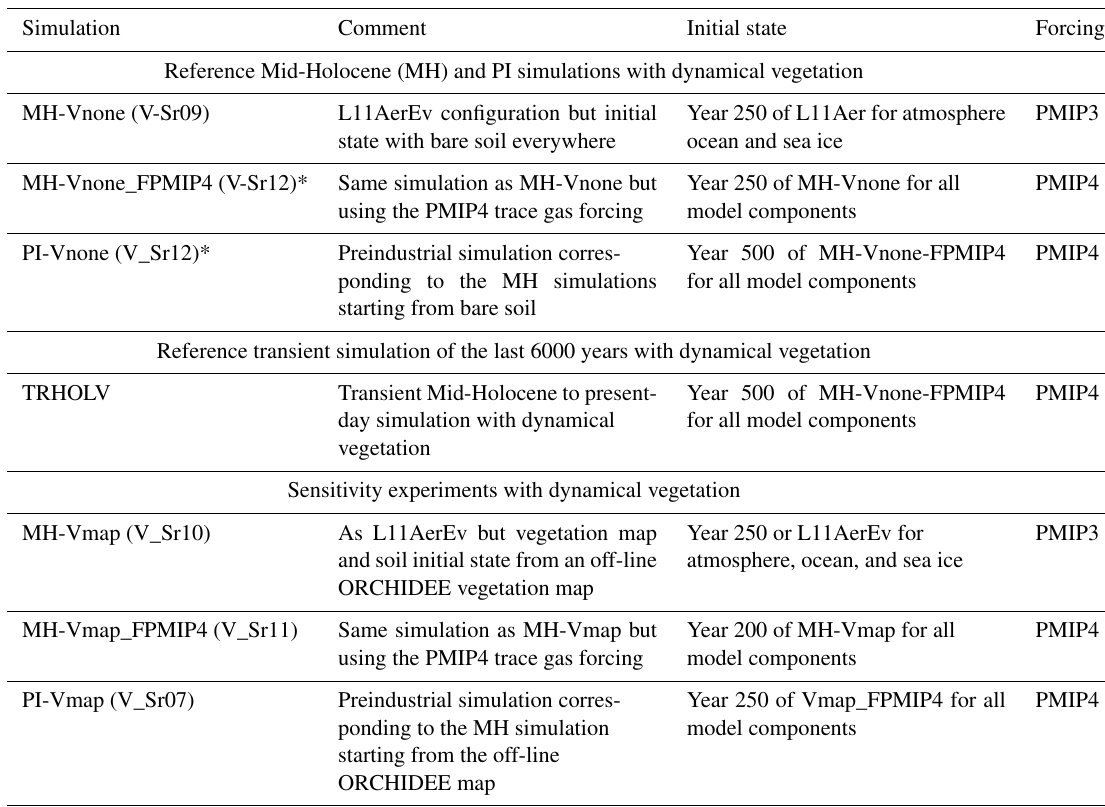
Table 2. Simulations run to initialize the dynamical vegetation starting from bare soil or from vegetation map and soil moisture resulting from an off-line ORCHIDEE simulation with dynamical vegetation switched on and using the PI L11 simulated climate as boundary conditions. We include in parentheses the tag of the simulation that corresponds to our internal nomenclature for